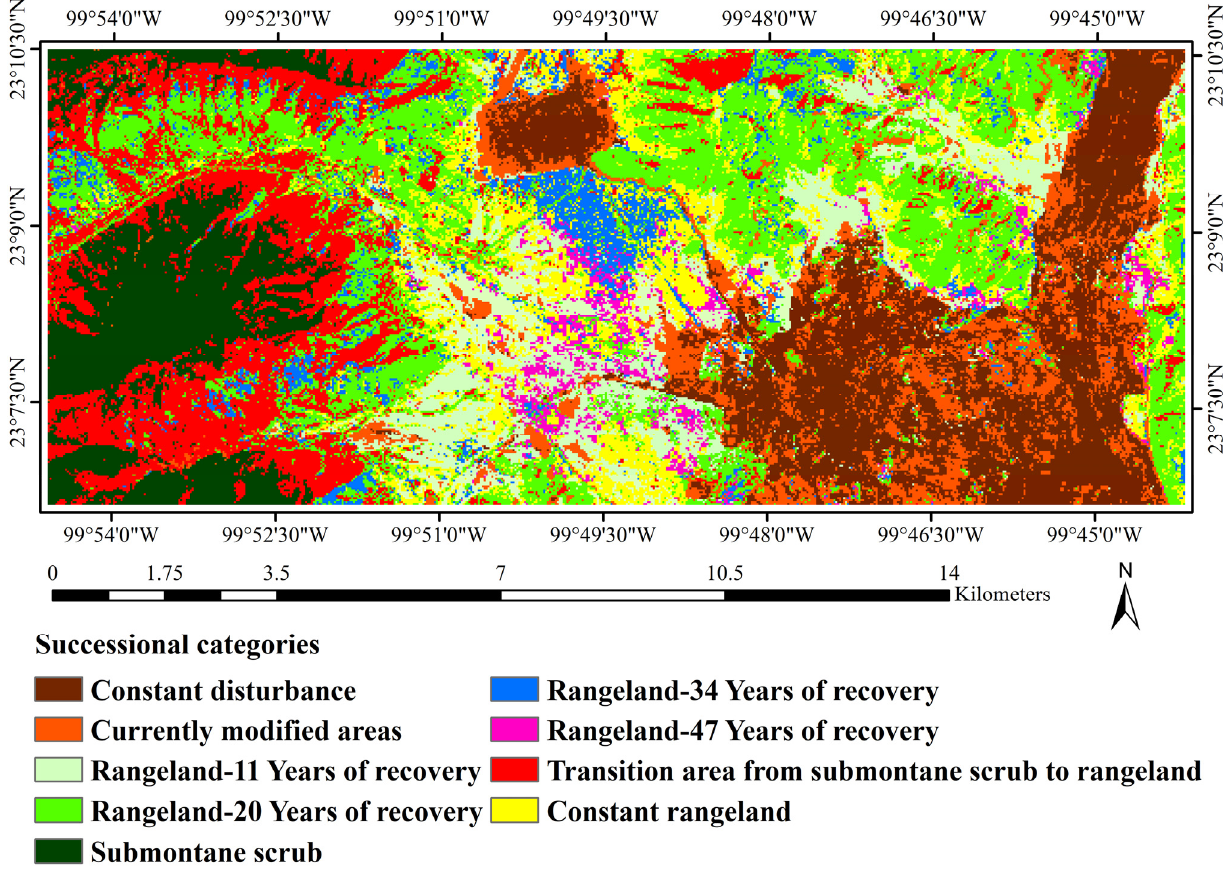
Figure 6. Successional categories of coverage and change in land use, San Rafael, Tula, Tamaulipas, Mexico.